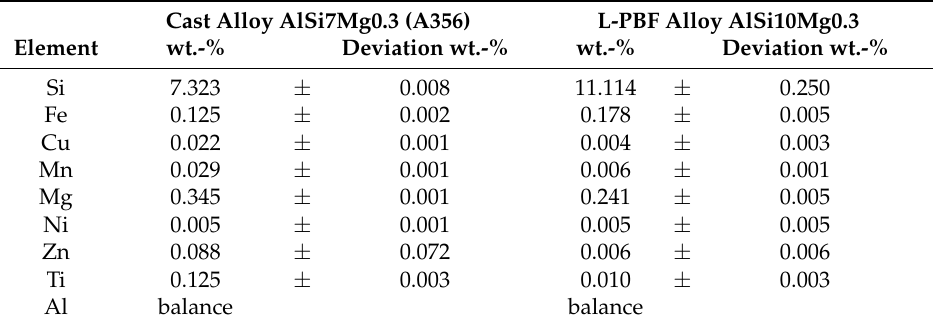
Table 1. Chemical composition of the aluminum cast alloys AlSi7Mg0.3 and AlSi10Mg0.3. The alloys meet the specifications defined by the standard Aluminum–Silicon EN 1706:2010 [37].